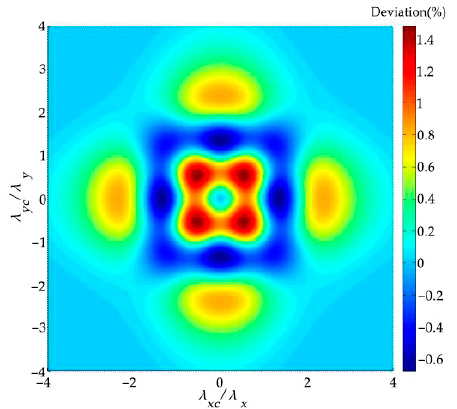
Figure 5. The deviation of amplitude-frequency characteristics between Gaussian filter and cascade approximating spline filter ( n = 2).